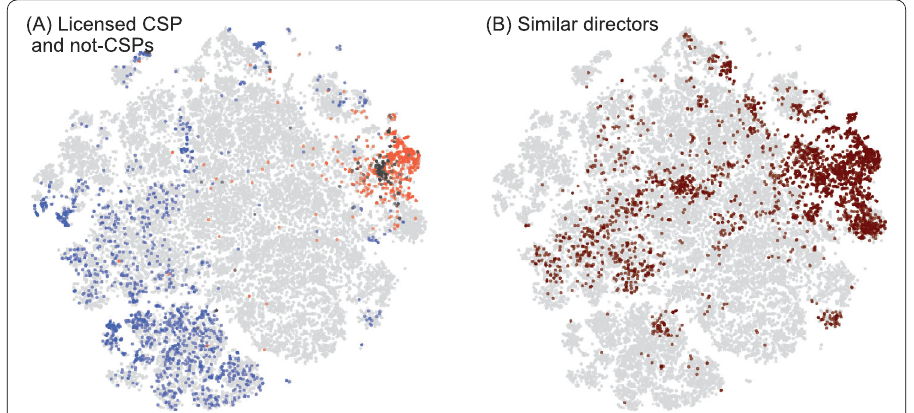
Figure 3 Visualization of the feature space using t-distributed stochastic neighbor embedding (t-SNE). Each point represents one director. Points that are near each other in the feature space appear close in the visualization. ( A ) Licensed CSPs are visualized in black (original list from the Dutch central bank) and red (augmented list as detailed in Sect. 3.1.2). Non-CSPs (see Sect. 3.1.3) are visualized in blue. ( B ) The nearest neighbors to the licensed CSPs are visualized in maroon. Only those points that are close to at least three CSPs are displayed (i.e., they are within the 100 closest neighbors of three